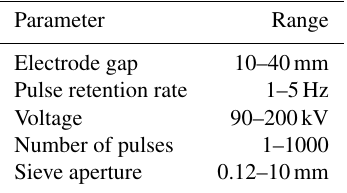
Table 2. Variable parameters of the SELFRAG Lab